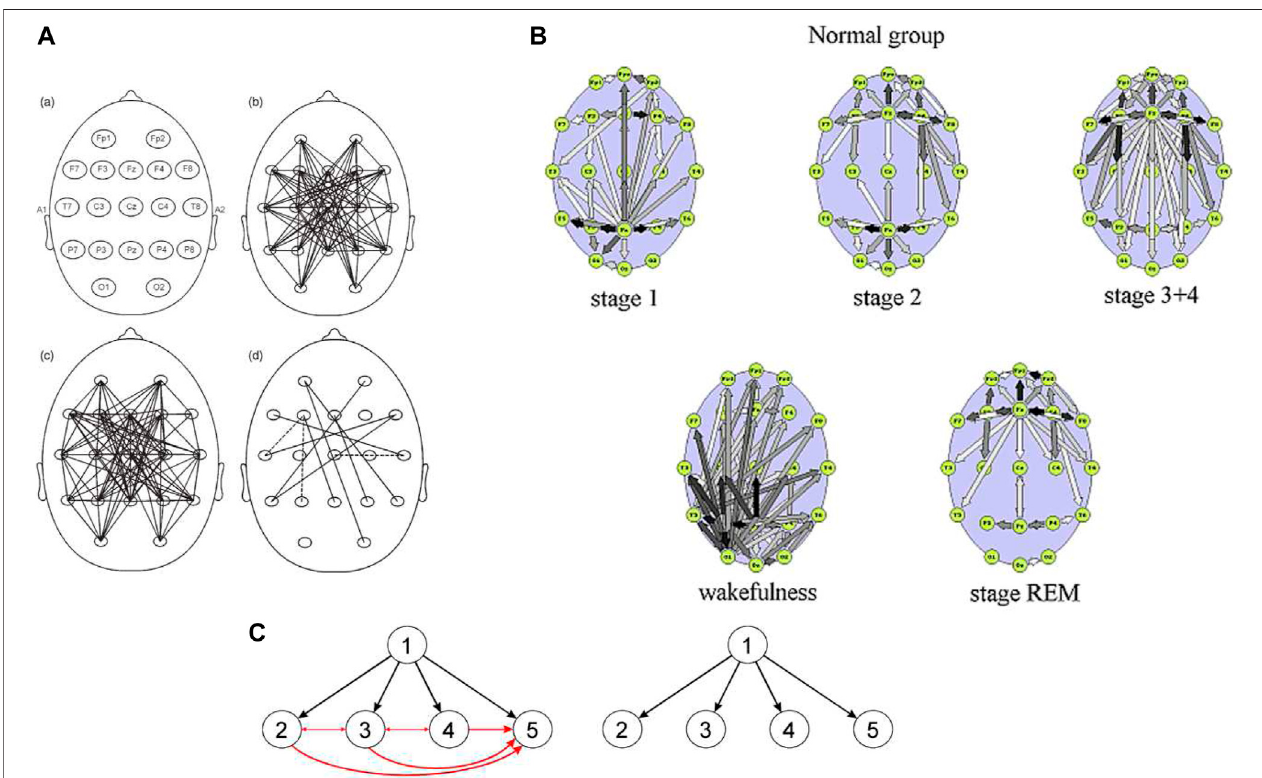
FIGURE 1 | Connectivity patterns during sleep. (A) Connectivity obtained by means of bivariate measure (SL) in delta band (slow wave sleep- SWS); b) for healthy subjects, c) for depressed subjects, d) differences between healthy and depressed subjects. (Leistedt et al., 2009). (B) . Connectivity patterns obtained in three sleep stages averaged over 9 healthy subjects (Kaminski et al., 1997). Stage 3 (SWS) corresponds to image A picture c), Adapted from (Kaminski et al., 1997; Leistedt et al., 2009)withpermission. (C) — imageatleftshowssimulatedschemeofpropagation(thiskindofschemeisobtainedbymultivariatemethods:DTForPDC).Imageat the right represents the connectivity scheme obtained by bivariate